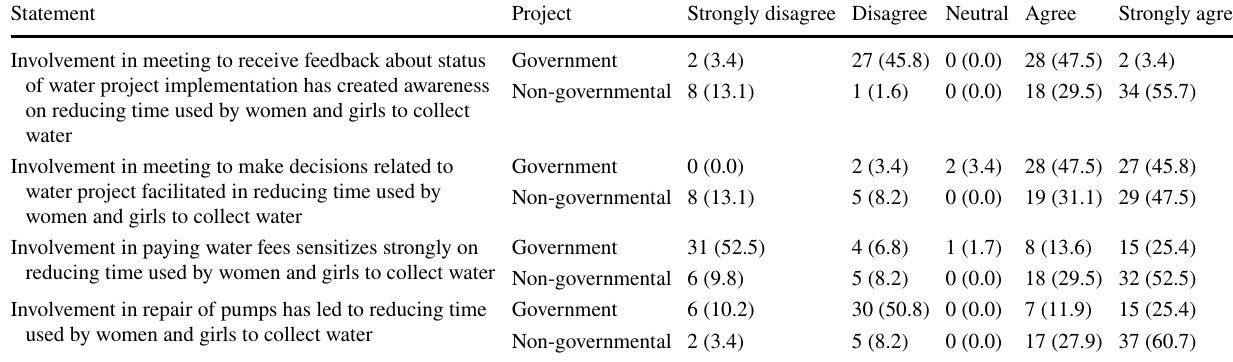
Table 8 Effectiveness of PM&E on reducing time used by women and girls to collect